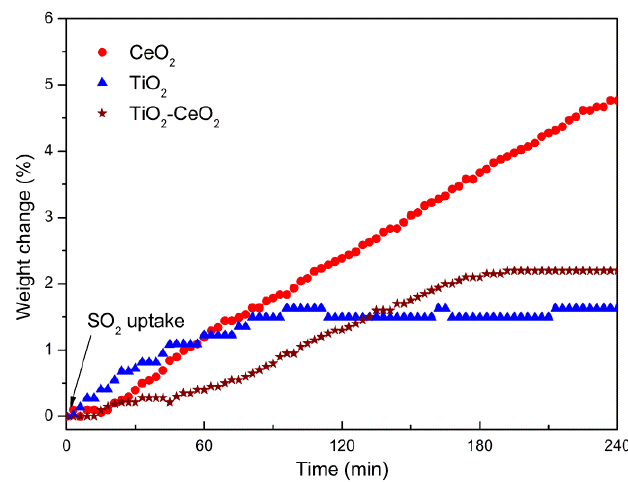
Figure 1. Sulfur uptake of the TiO 2 , TiO 2 -CeO 2 and CeO 2 catalysts.